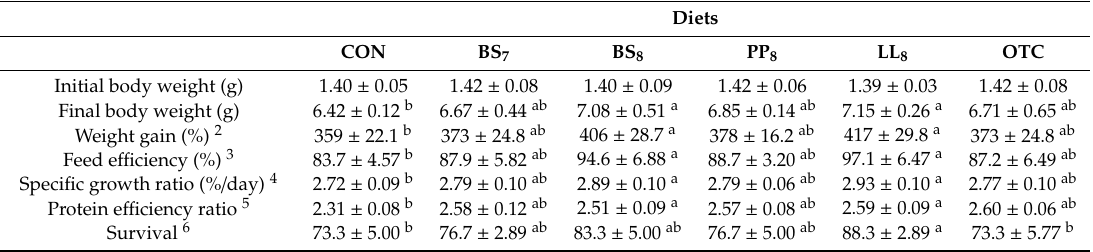
Table 3. Growth performance and feed utilization of juvenile whiteleg shrimp fed the experimental diets for 8 weeks 1 .